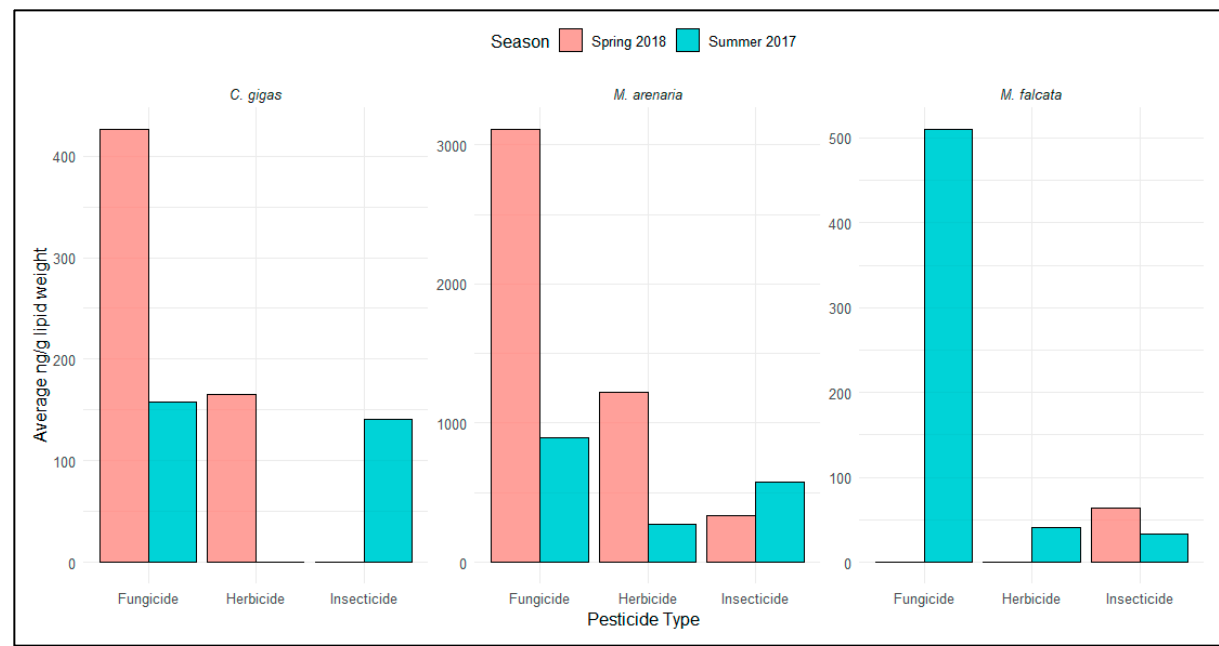
Figure 4. Seasonal changes in mean fungicide, herbicide, and insecticide lipid-normalized concentrations in C. gigas , M. arenaria , and M. falcata tissues. Due to low population sizes, collection sites of M. falcata differ by season. Note the differences in the y-axis scales .